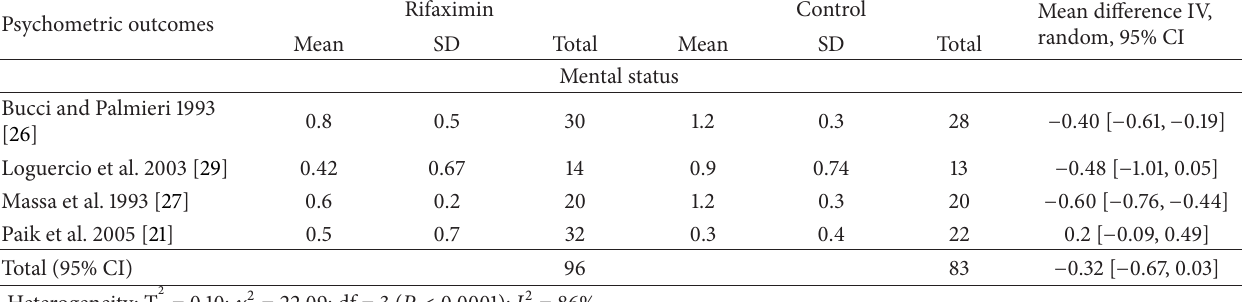
Table 3: Meta-analysis of psychchometric outcomes between rifaximin and nonabsorbable disaccharides. Psychometric